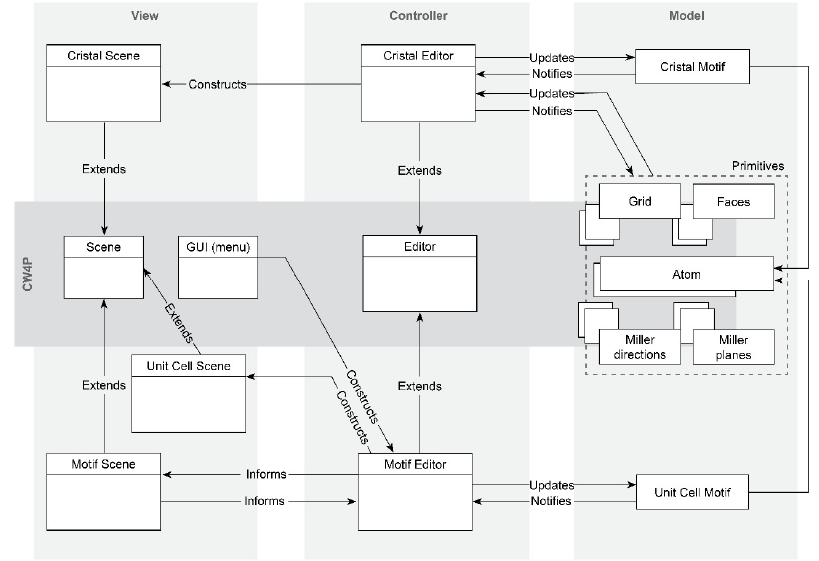
Figure 5. Implementation of the CW4P design pattern in the CWAPP application architecture. Source: adapted from [10].